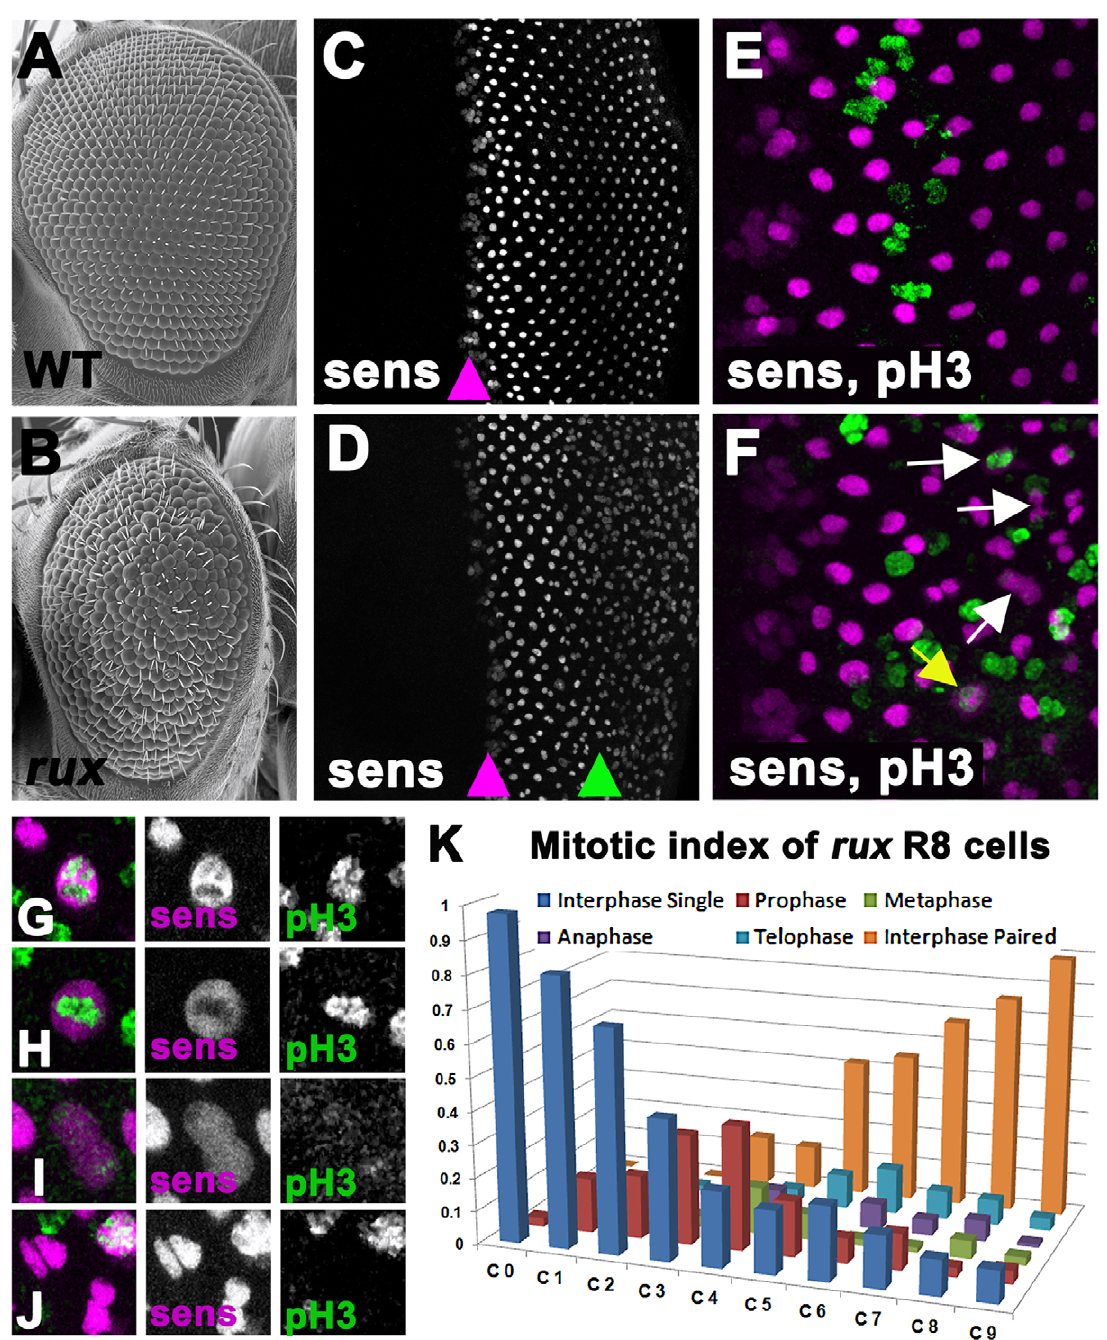
Figure 1. Mitotic R8 cells re-enter the cell cycle in rux mutants. Scanning electron micrographs of the wild type (A) and rux (B) adult eyes. In both wild type (C) and rux (D) third instar eye discs, normal Sens staining appears in intermediate group cells (purple arrowheads) before becoming isolated to single R8 cells. In rux R8 nuclei become disorganized after their number increases (D, green arrowhead). Mitotic figures labeled with H3p (green) are seen only in non-neuronal cells during the Second Mitotic Wave of wild type eye discs (E), but in rux discs (F) mitotic R8 cells and paired R8 nuclei are also seen (yellow and white arrows). G–K. Mitotic R8 cells from a rux eye disc in prophase (G), metaphase (H), anaphase (I), and as closely paired nuclei (J). K. Mitotic index of R8 cells showing the fraction of mitotic R8 cells in each of the first 10 columns (n=5 eye discs and 620 R8 cells). See also Figure S1. considerably less effective at inhibiting CDK1 [40–43]. Cell cycle blocks the second mitotic wave in wild type, without affecting progression was monitored by labeling for mitotic H3p and for progenitor cell proliferation anterior to the morphogenetic furrow Cyclin B, which accumulates in cells between S-phase entry and [38](Figure 2C, 2D). In rux mutant eye discs, G1 arrest ahead of mitotic metaphase [44,34](Figure 2A, 2B). GMR-p21 completely the furrow was less effective and ended prematurely, with high